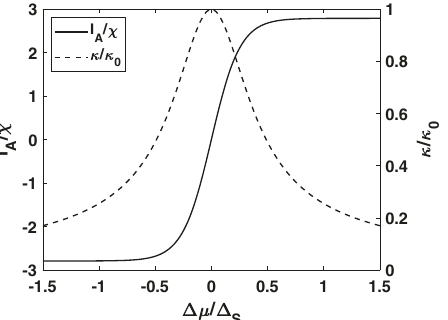
Fig. 3 Tunneling current and conductance. The solid and dashed lines respectively depict the tunneling current and conductance between two reservoirs as a function of chemical potential bias Δ μ . Here χ ¼ Ω 2 Ω 2 mk = π E 2 is the normalizing constant for the current, κ 0 is the " ; 3 # ; 3 F F constant taken at Δ μ = 0. Values of the chemical potential μ S and gap energy Δ S for the super fl uid phase are set to be the experimental values in the unitary limit, μ S / E F = 0.38 and Δ S / E F = 0.47, while T is set as T / T = 0.06 38,39 ( E T F F and F are the Fermi energy and Fermi temperature of the super fl uid reservoir, respectively).